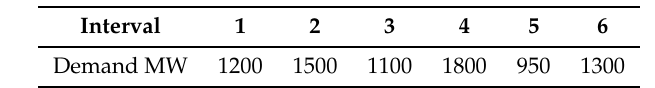
Table 5. Load demand for each scheduling interval (each interval is 12 hours, making a total scheduling period of 3 days).